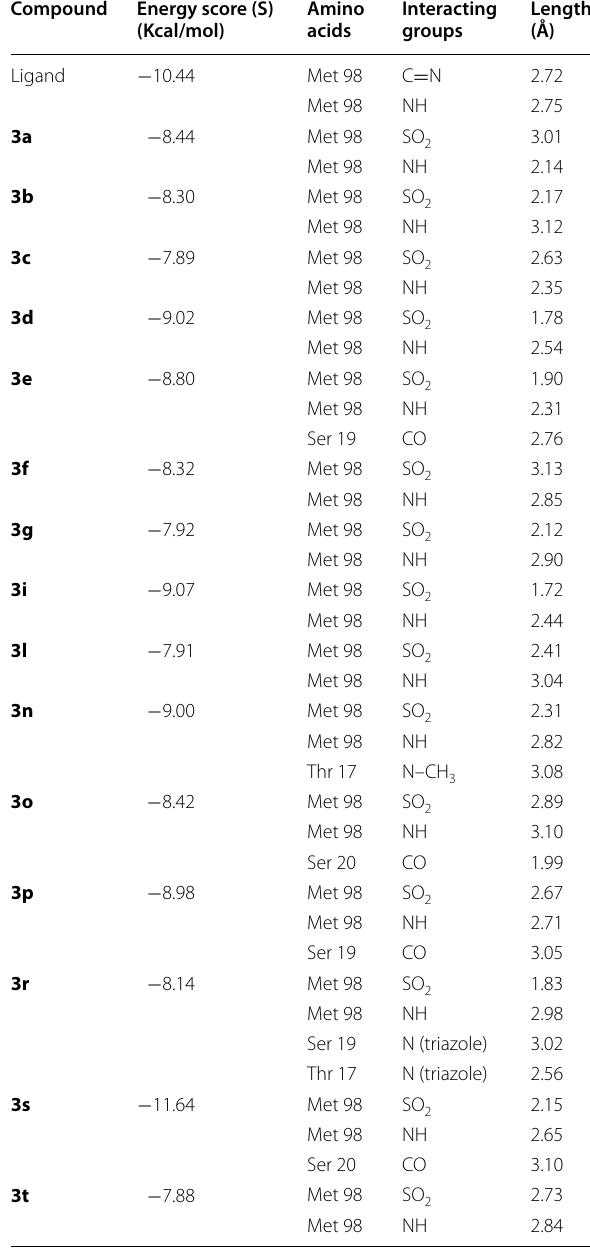
Table 3 Docking results of the targeted compounds inside 5JFO active